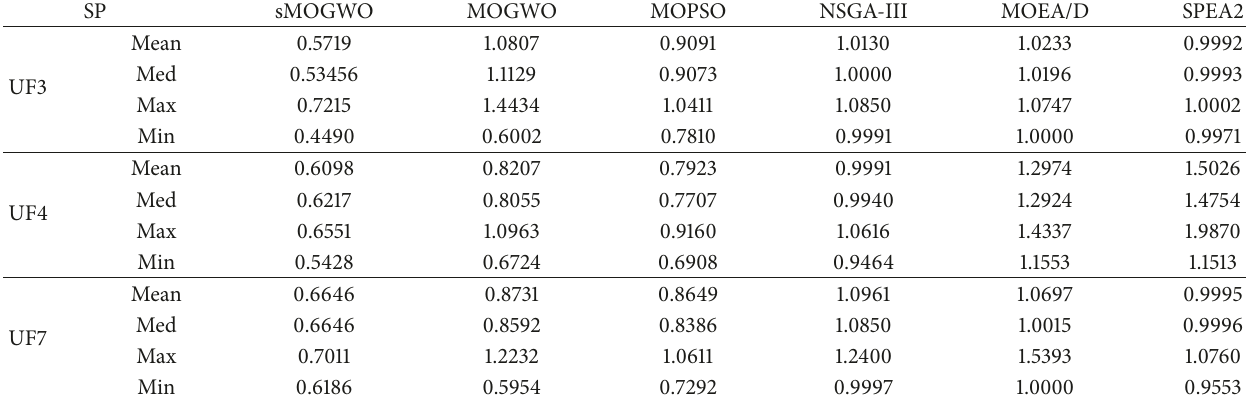
Table 3: Statistical results of SP for different